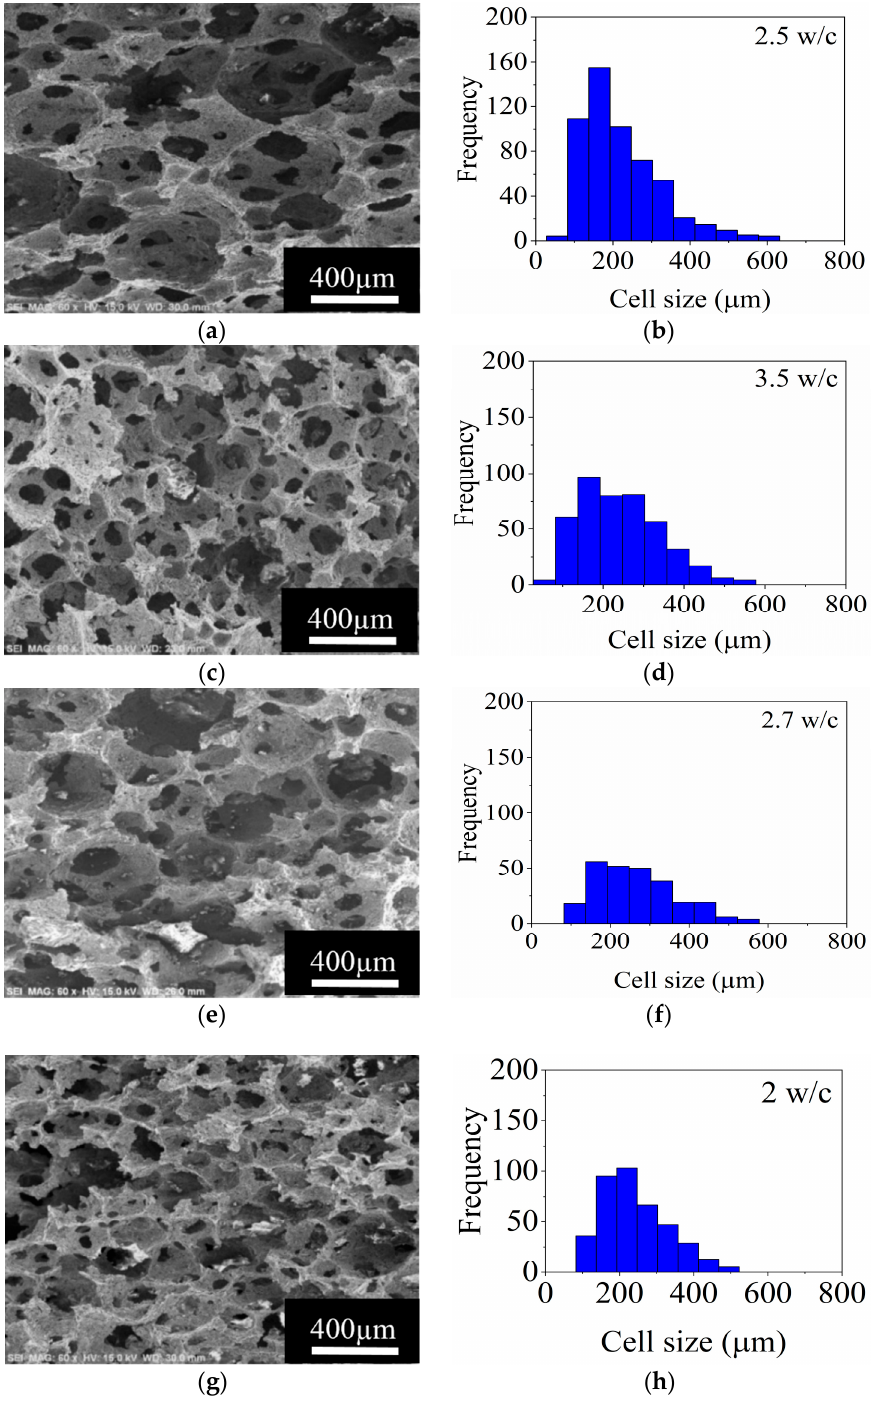
Figure 9. SEM micrographs and frequency histograms for the cell size of ceramic foams prepared with stirring times of: ( a ) and ( b ), 1 min; ( c ) and ( d ), 2 min; ( e ) and ( f ), 3 min; and ( g ) and ( h ), 4 min, respectively, with a load of 37 vol.% MgAl 2 O 4 and 3 wt.% SE for a stirring rate of 1070